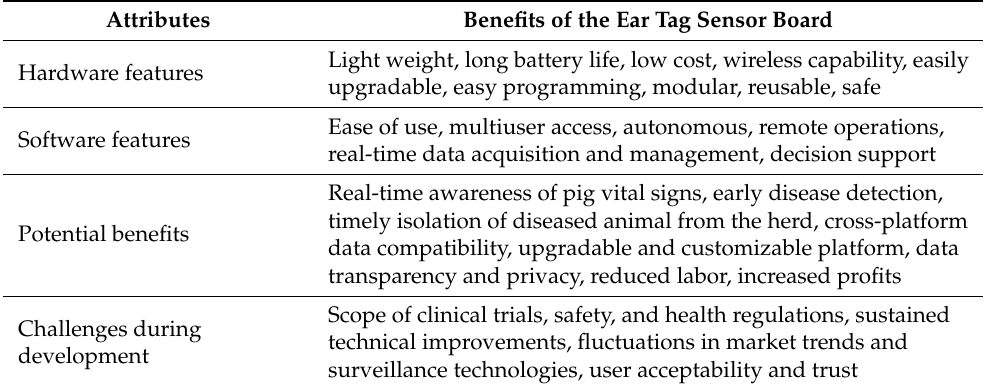
Table 2. Attributes and benefits of the ear tag sensor board for the pig farmer. Attributes